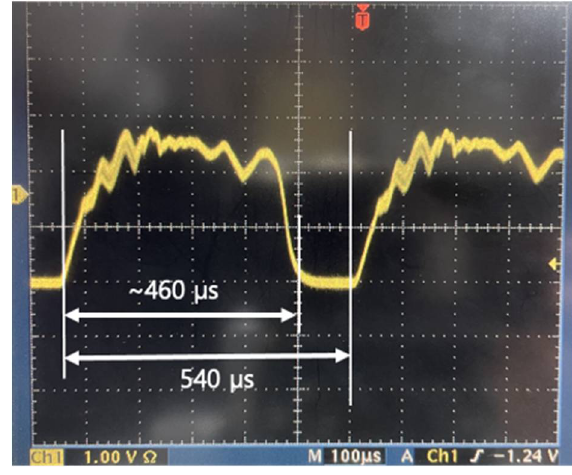
Figure 6. Photograph of the output signal of the WSL on an oscilloscope. The beam from the WSL was incident on the CLC cell, and the transmission spectra for the first-order reflection with respect to the intensity of the electric field applied to the CLC cell is observed. Figure 7a–c shows the optical spectra of the reflection band when the applied electric field is 2.70, 3.42, and 3.77 V rms / µ m, respectively. The wavelength of the arrow indicated in the figures is the wavelength of the short-band edge of the reflection band. When an electric field of 2.70 V rms / µ m or more was applied to the CLC cell, the short edge of the reflection band shifted to 1044 nm from 1022 nm. When the electric field applied to the CLC cell increased, the reflection band moved to longer wavelength discontinuously, owing to the pitch jump, which occurred instantaneously [19]. When an electric field of 3.42 V rms / µ m or more was applied, the short edge shifted to 1071 nm, as shown in Figure 7b. Because the OSA’s response to the wavelength change was slow, it was not easy to observe the abrupt change in the reflection band spectrum, owing to the instantaneous pitch jump. However, when the dynamic variations of the WSL were observed in the temporal domain, using an oscilloscope and high-speed photodetector, the process of changing the wavelength of the reflection band owing to the instantaneous pitch jump could be observed. Figure 7d–f shows the oscilloscope displays of the first- order reflection band when the applied electric field was 2.70, 3.42, and 3.77 V rms / µ m, respectively. These correspond to Figure 7a–c, respectively. On the oscilloscope, if the electric field applied to the CLC cell was continuously increased, it could be observed in real time that the short-band edge of the reflection band was instantaneously moved by the pitch jump at any moment. As an example, when the electric field increased from 3.42 to 3.77 V rms / µ m, the pitch jump occurred in the CLC cell. Supplementary Material Videos S1 and S2 show videos of the in situ variation of the first-order reflection band spectrum, owing to the dynamic pitch jump of the CLC cell, on the oscilloscope. Supplementary Material Video S1 shows a video in which the reflection band changes when the electric field applied to the CLC cell increases from 3.42 to 3.77 V rms / µ m and Supplementary Material Video S2 shows the electric field applied to the CLC cell is increased from 3.77 to 4.13 V rms / µ